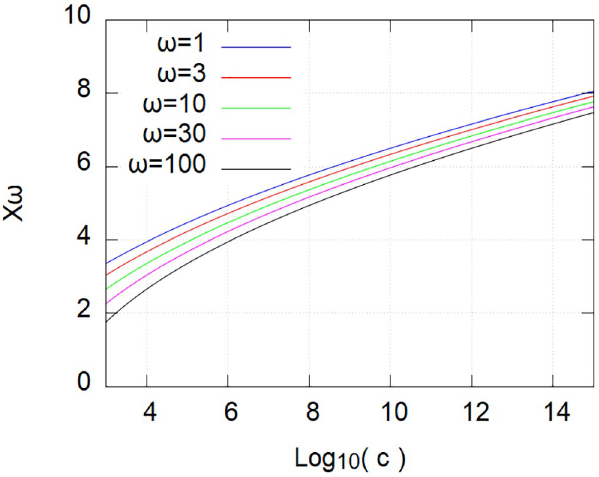
Fig 1. Variation of X ω with the complexity c for different values of ω . See text.